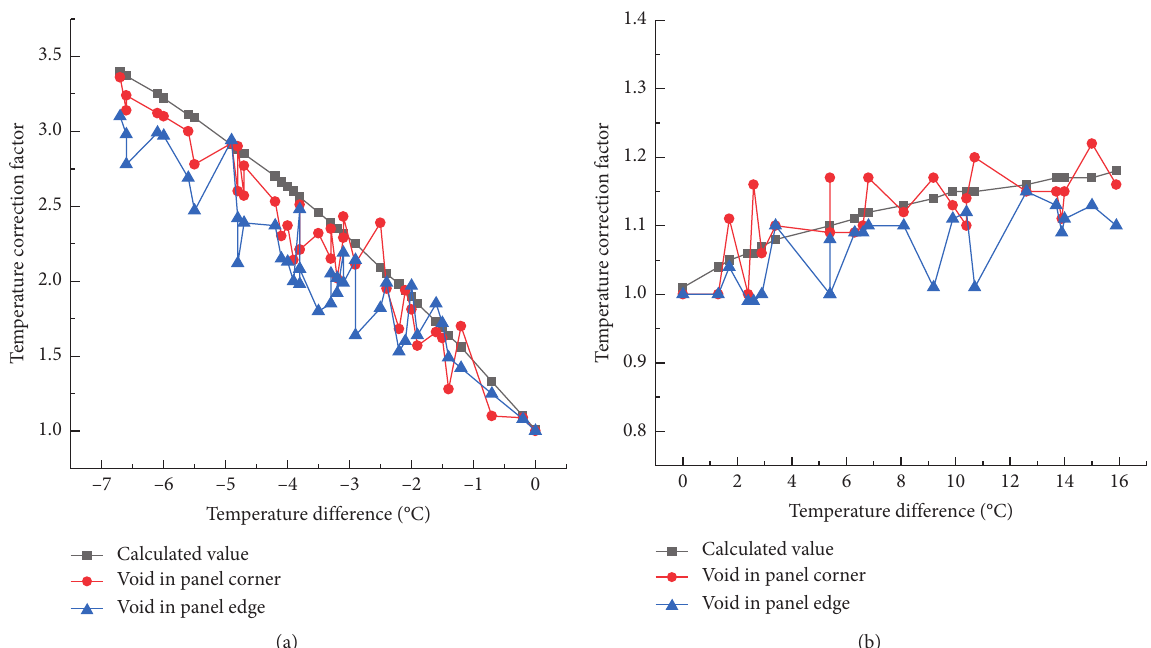
Figure 14: Comparative analysis of model calculated values and field test results. (a) Negative temperature range. (b) Positive temperature